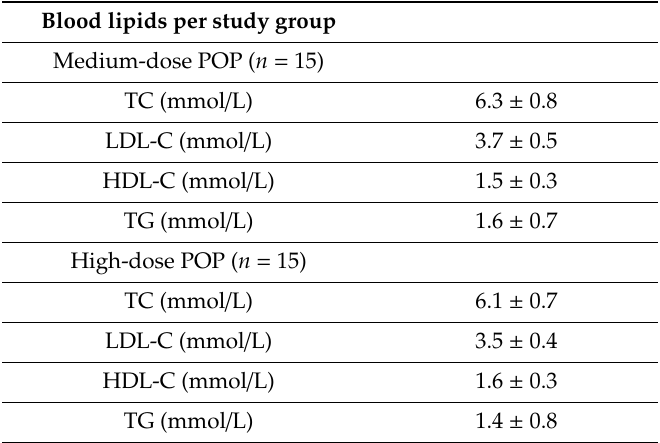
Table 2. Anthropometric characteristics and blood lipids of study participants at the baseline. Blood lipids per study